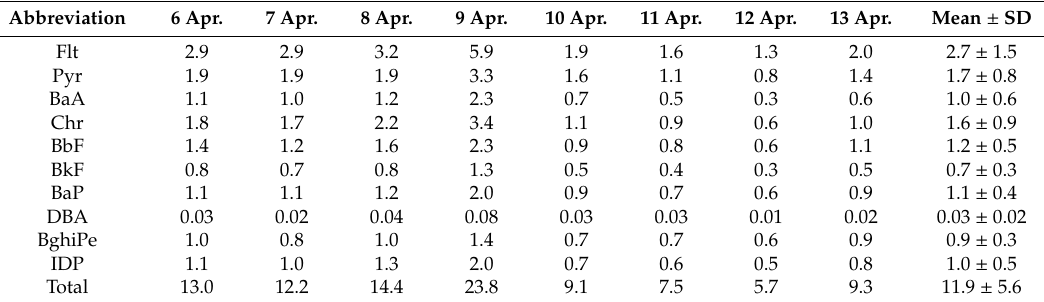
Table 3. Daily and weekly mean concentrations of polycyclic aromatic hydrocarbons (PAHs) in atmospheric PM 10 of Lijiang (ng / m 3